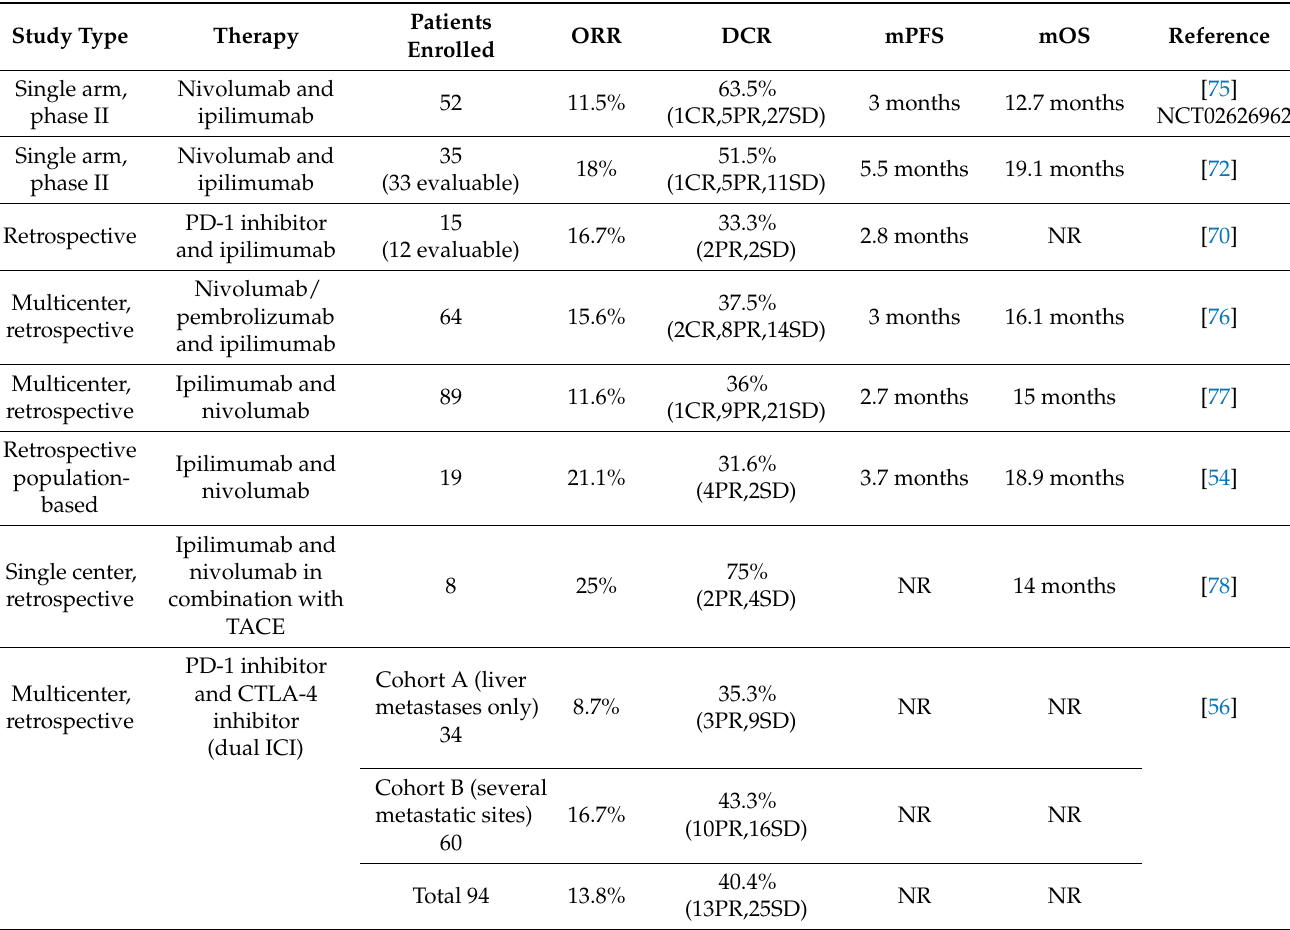
Table 4. Clinical studies with combined PD-1 and CTLA-4 inhibitors in metastatic UM